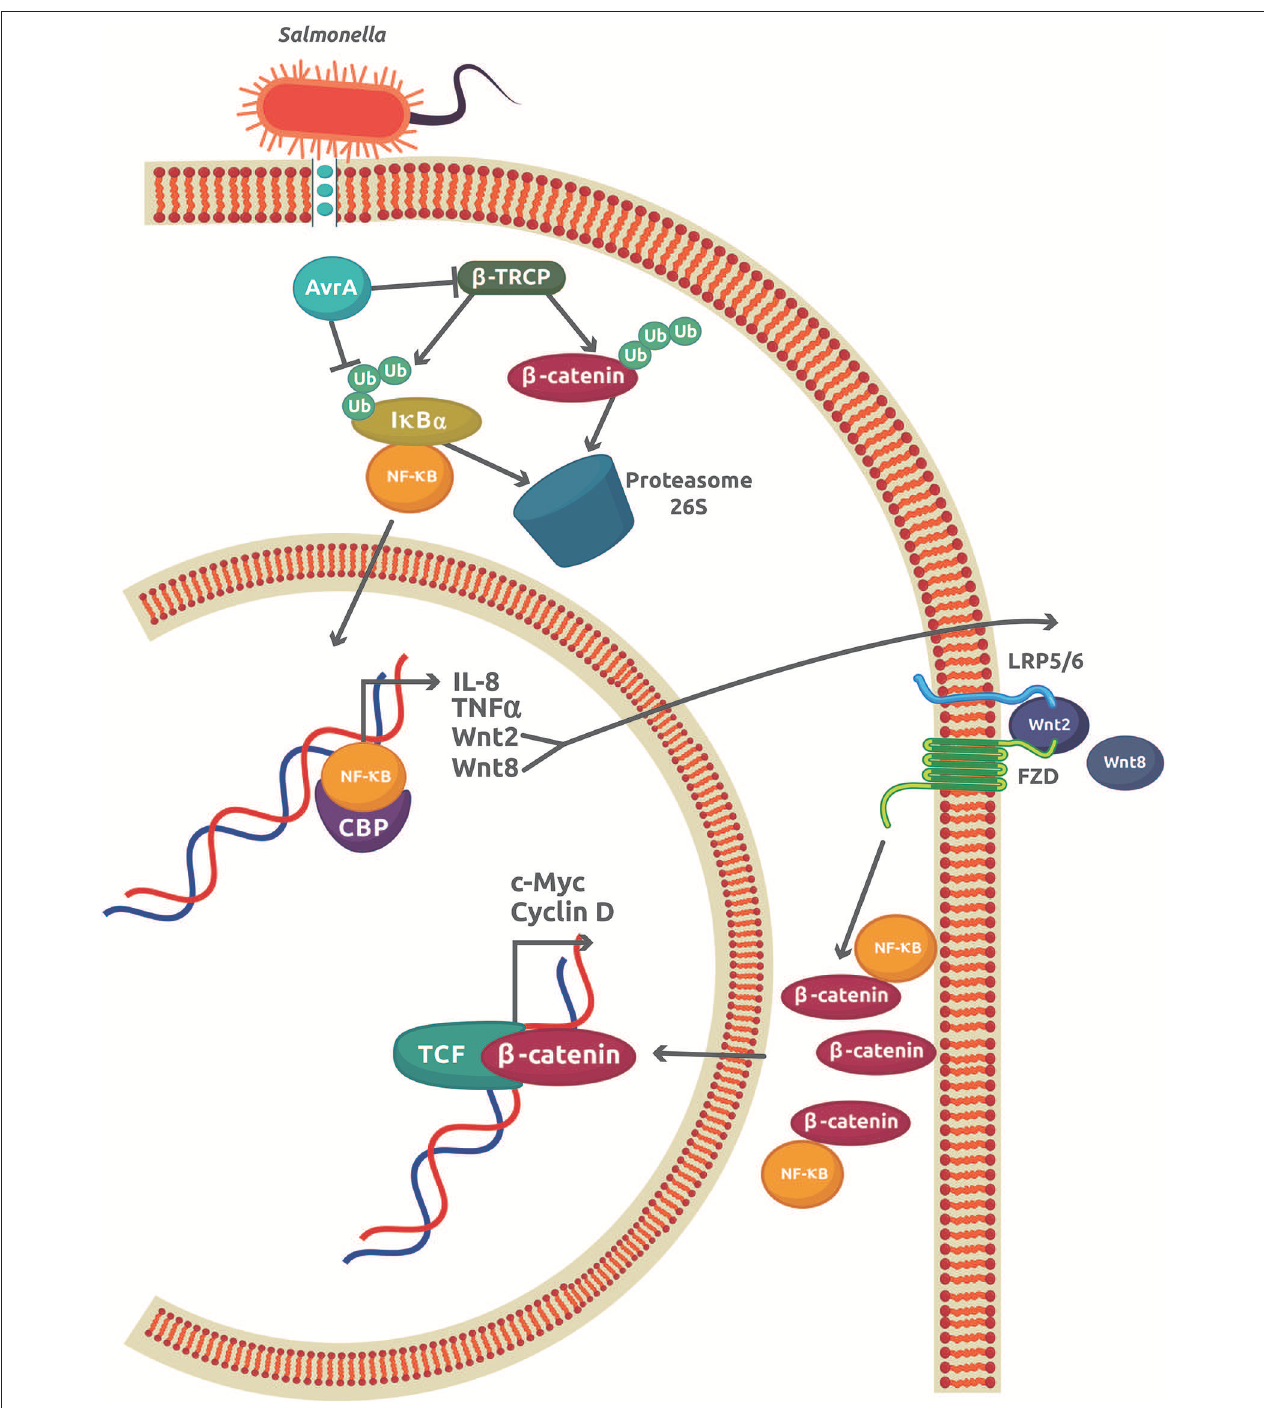
FIGURE 2 | The AvrA virulence factor from S. enterica sv Typhimurium inhibits the inflammatory response in epithelial cells. The initial inflammatory response promoted by interaction of S. enterica with TLRs leads to an increase in the NF- κ B activity and expression of the classical genes, IL-8 and TNF α , and also to Wnt2 and Wnt8. The autocrine effect of Wnt2/8 is to promote the cytoplasmic accumulation of β -catenin. Part of this β -catenin reduces the amount of free NF- κ B by forming a complex with the NF- κ B p50 subunit. S. enterica injects the virulence factor Avra through a type 3 secretion system. AvrA is also able to both inhibit the activity of β -TRCP and directly deubiquitinate I κ B α , which increases the stability of the I κ B α -NF- κ B cytoplasmic complex and reduces the free NF- κ B.